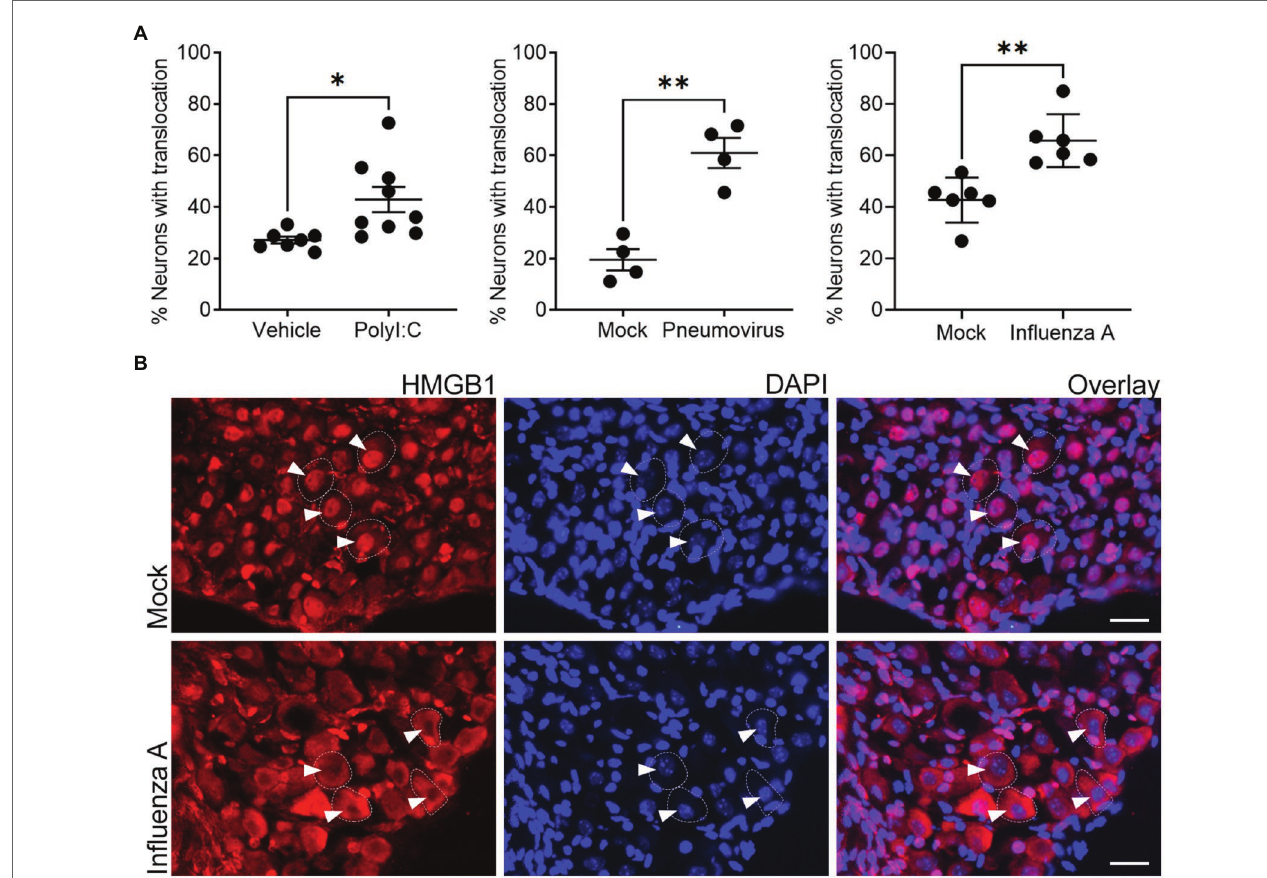
FIGURE 4 | In vivo exposure to viral mimetic or respiratory viral infection evokes nuclear to cytoplasm translocation of HMGB1 in vagal sensory neurons. (A) Significantly more frequent cytoplasmic HMGB1 staining was observed in vagal sensory neurons following in vivo inoculation with either the viral mimetic PolyI:C or viral infection with murine pneumovirus and influenza A virus (IAV) in wildtype mice. The quantitative data represent the percentage of neurons with detectable cytoplasmic HMGB1 staining. Each dot represents the average of 825 ± 154 neurons per animal with the overall group mean and SEM plotted. (B) Representative photomicrographs show examples of the redistribution of HMGB1 staining in vagal sensory neurons following influenza A respiratory viral infection. Vagal sensory ganglia were collected at 7 dpi for all conditions and tissue sections stained for HMGB1 and the nuclear marker DAPI. Dashed outlines indicate example neurons. Arrowheads point to neuronal nuclei (as determined by DAPI stain). * p < 0.05 and ** p < 0.01 significantly different to time-matched vehicle/mock control as determined by unpaired t test scale bar=25